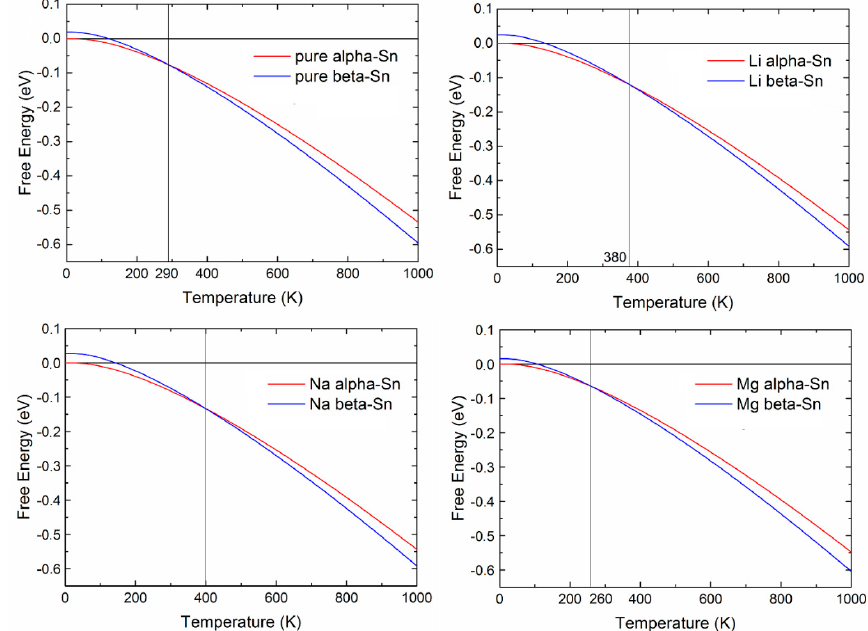
Figure 5. Helmholtz free energies—offset by the value of (pure or doped) α -Sn at 0 K—against temperature for pure and Li/Na/Mg-doped Sn (in eV). The vertical lines indicate the intersection points where phase transition is expected. Reprinted with permission from [23], © (2015) Elsevier.